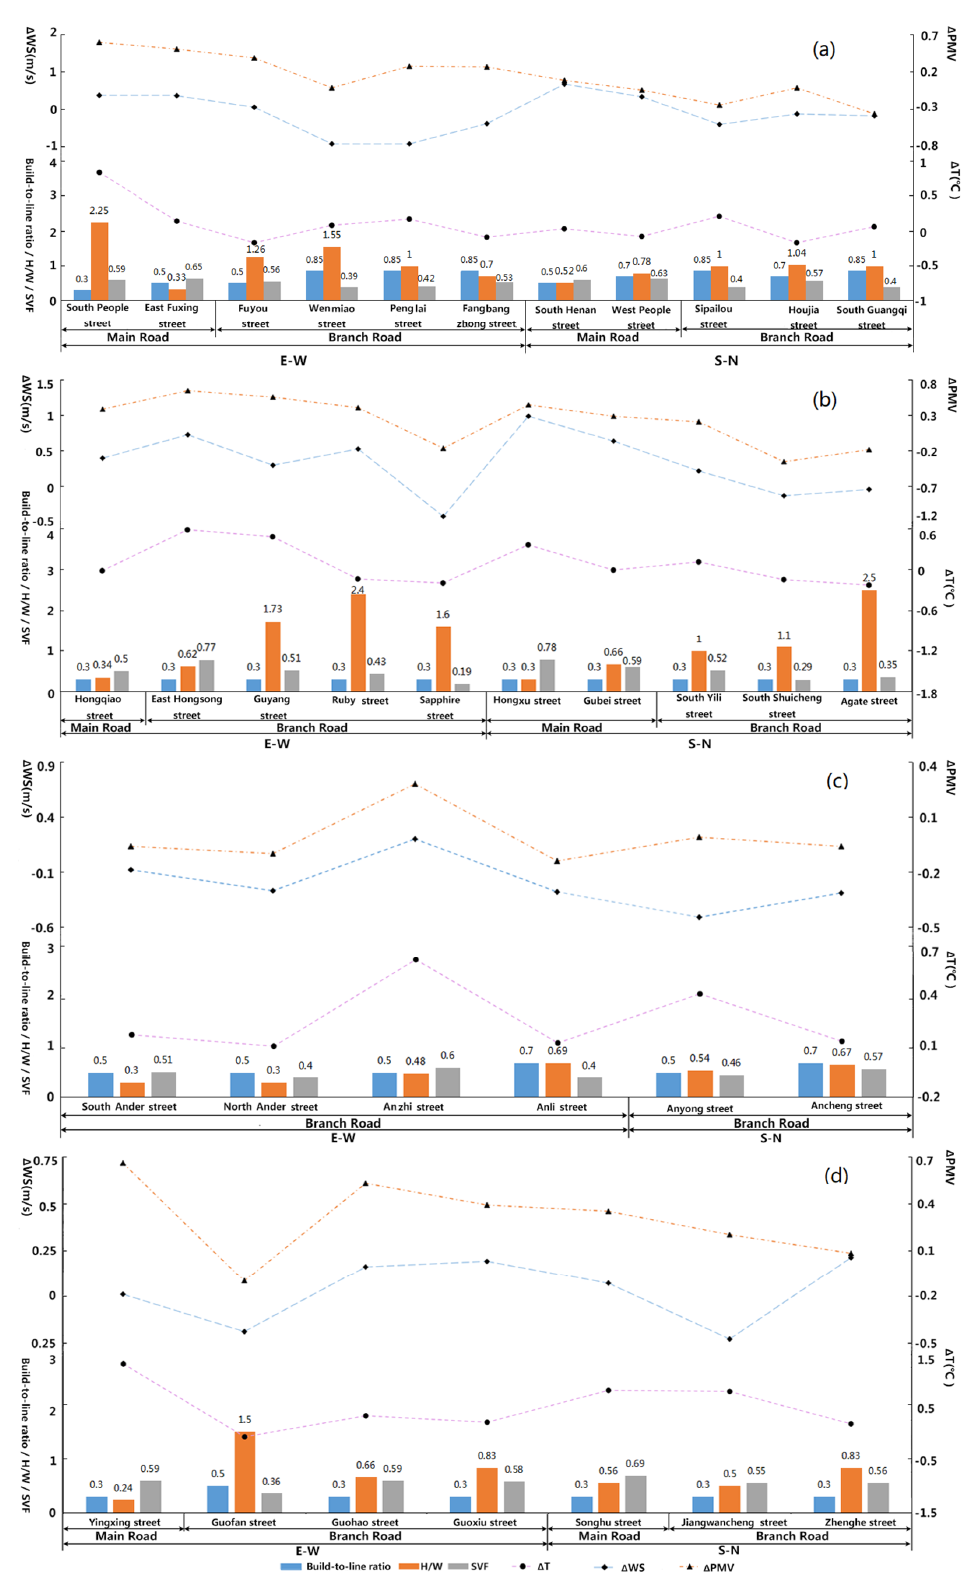
Figure 14. Spatial correlation comparison diagram of the four study zones between the morphological indexes and microclimate factors at street-site level for the four study zones (( a ) Old downtown, ( b ) Gubei international community, ( c ) Anting New Town zone, and ( d ) New Jiangwan Town zone).